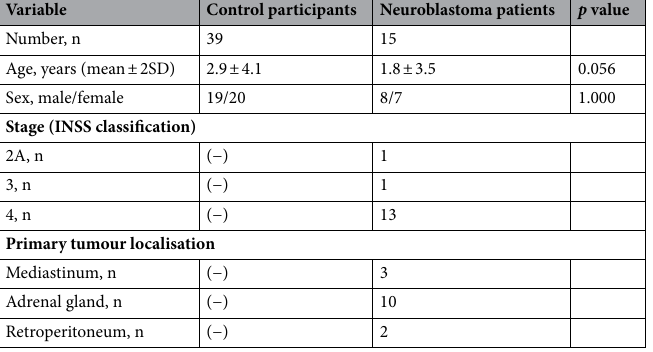
Table 1. Patient and control characteristics. SD standard deviation, INSS International Neuroblastoma Staging System, (−) not